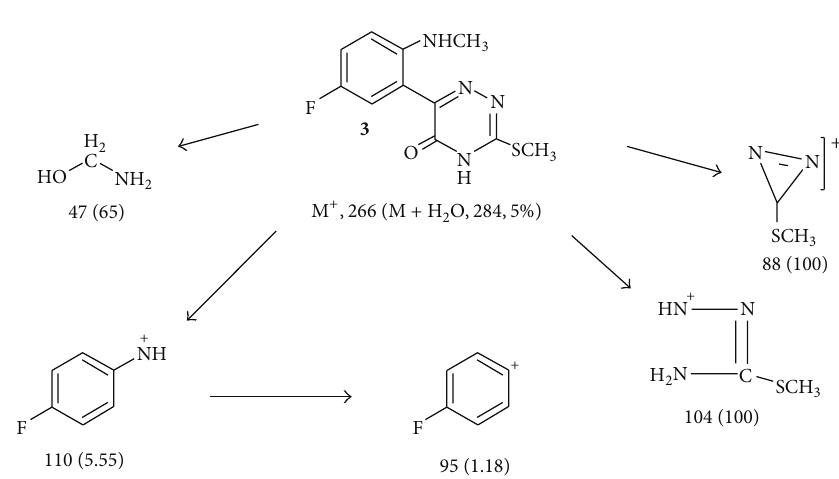
Scheme 7: Mass fragmentation pattern of compound 3